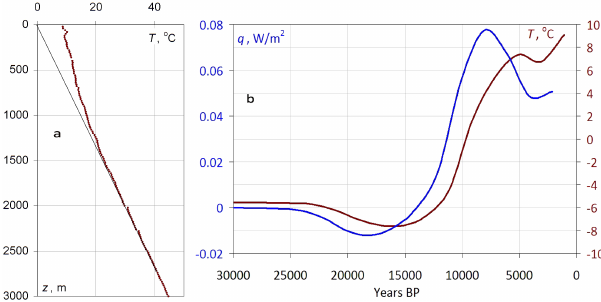
Figure 2. Initial data and surface heat flux (a) temperature–depth profile from the borehole SG-4 (Demezhko and Shchapov, 2001, brown line), (b) GST history T ( t ) ( a = 1 . 0 × 10 − 6 m 2 s − 1 , De- mezhko and Shchapov, 2001, brown line) and calculated according to Eqs. (1)–(5) SHF history q ( t ) ( E = 2500Jm − 2 K − 1 s − 1 / 2 , blue